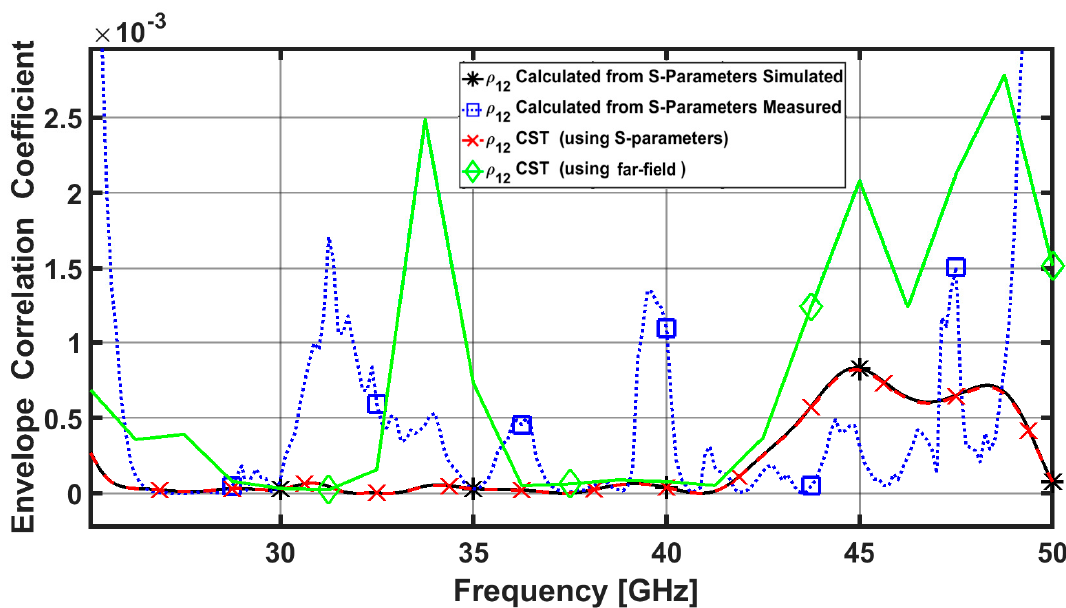
Figure 7. ECC of the proposed four-element MIMO antenna between port 1 and 2.